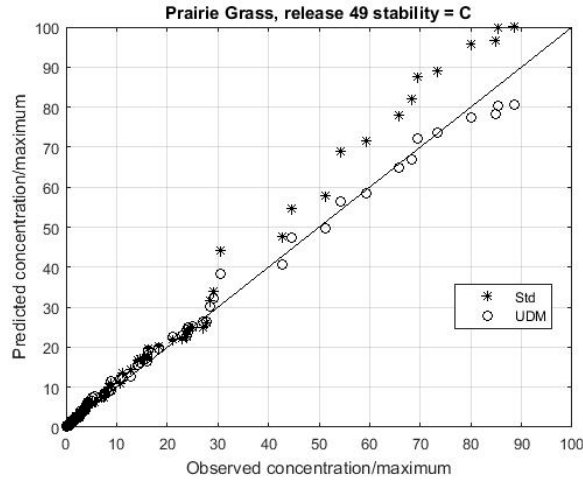
Figure 9. Quantile–quantile plot comparing predictions from simple analytical model defined in Appendix B denoted (Std) and the UDM code against observed concentrations for Prairie Grass release 49.